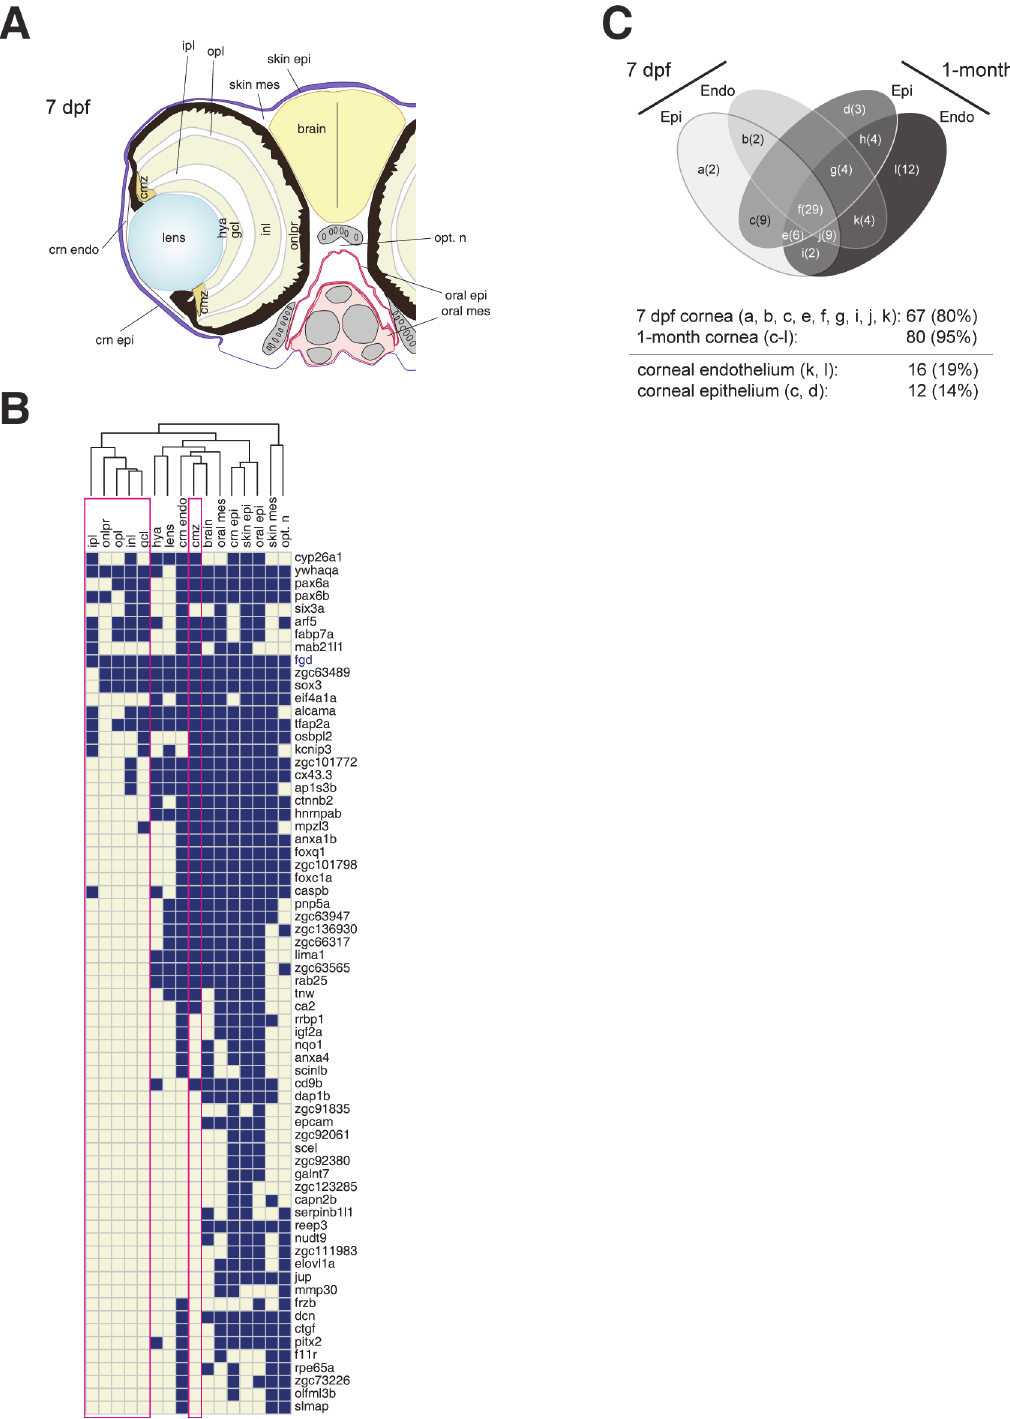
Fig 5. Expression of cornea genes in 7-dpf wildtype embryos in selected anatomical structures. (A) Schematic showing the 16 anatomical structures scored in the gene expression analysis: corneal epithelium (crn epi), corneal endothelium (crn endo), lens, ciliary marginal zone (cmz), hyaloid membrane (hya), ganglion cell layer (gcl), inner plexiform layer (ipl), inner nuclear layer (inl), outer plexiform layer (opl), outer nuclear layer-photo receptor (onlpr), skin mesenchyme (skin mes), skin epithelium (skin epi), brain, optic nerve fiber (opt. n), oral epithelium (oral epi) and oral mesenchyme (oral mes). (B) Cluster analysis of gene expression based on anatomical structures. The horizontal axis represents 16 anatomical structures and the vertical axis “ cornea ” genes. Among the examined genes (84 in total), only those with corneal expression are shown (67 genes). The columns surrounded by red rectangles indicate